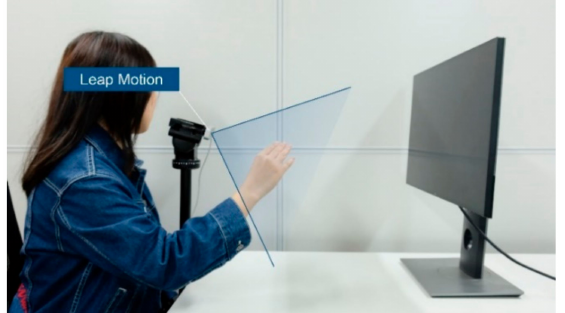
Figure 13. Schematic diagram of measurement using Leap Motion.